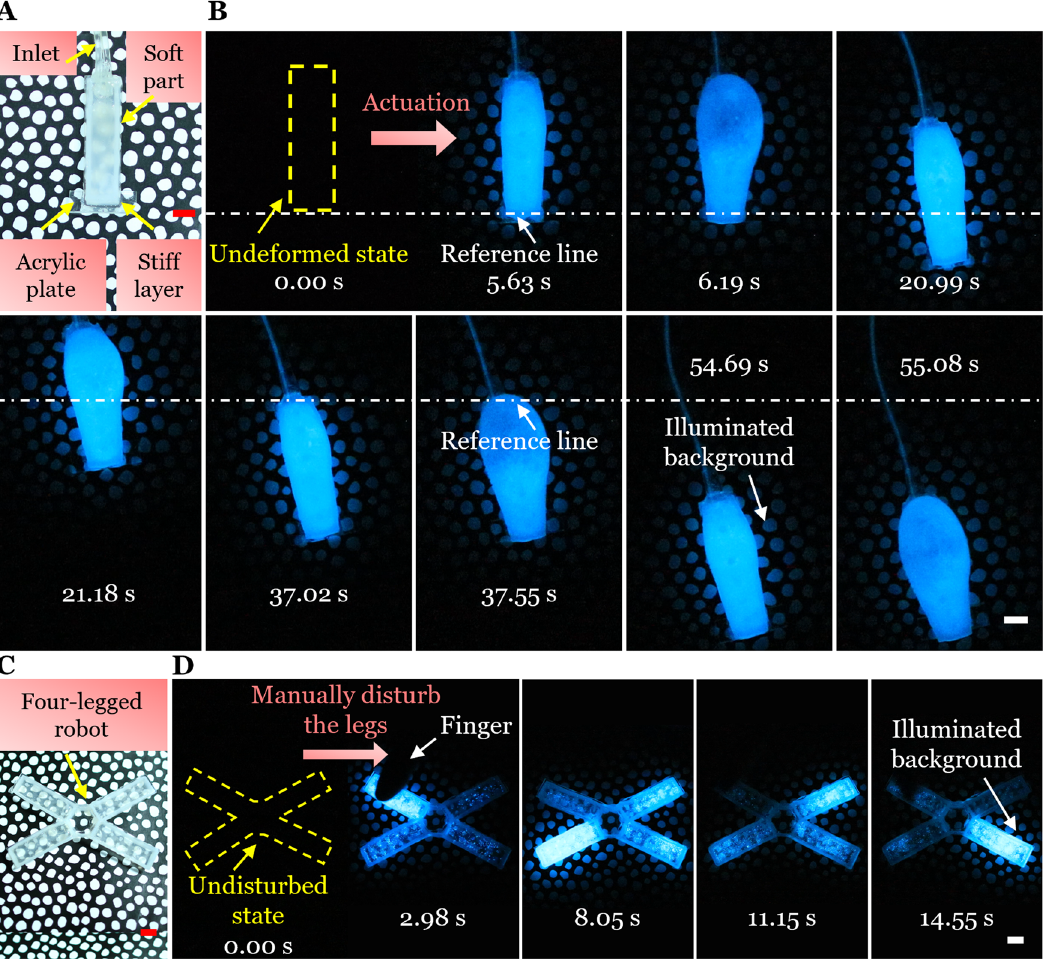
Fig. 5 Active actuation-induced or passive mechanical perturbation-induced illumination of the biohybrid mechanoluminescent actuator/robot in the dark. A A hydraulically actuated soft crawling robot. B Undeformed and actuated states of the soft robot in the dark at different times. Upon hydraulic actuation, the soft robot in fl ated and crawled forward and simultaneously produced light to make the surrounding background visible. C An untethered tetrapod-like soft robot with four legs. D Undisturbed and disturbed states of the four-legged robot in the dark at different times after mechanical disturbance. Pressed by a fi nger, the disturbed leg generated the brightest bioluminescence and illuminated the surrounding background while other legs produced much weaker bioluminescence. All scale bars are 1